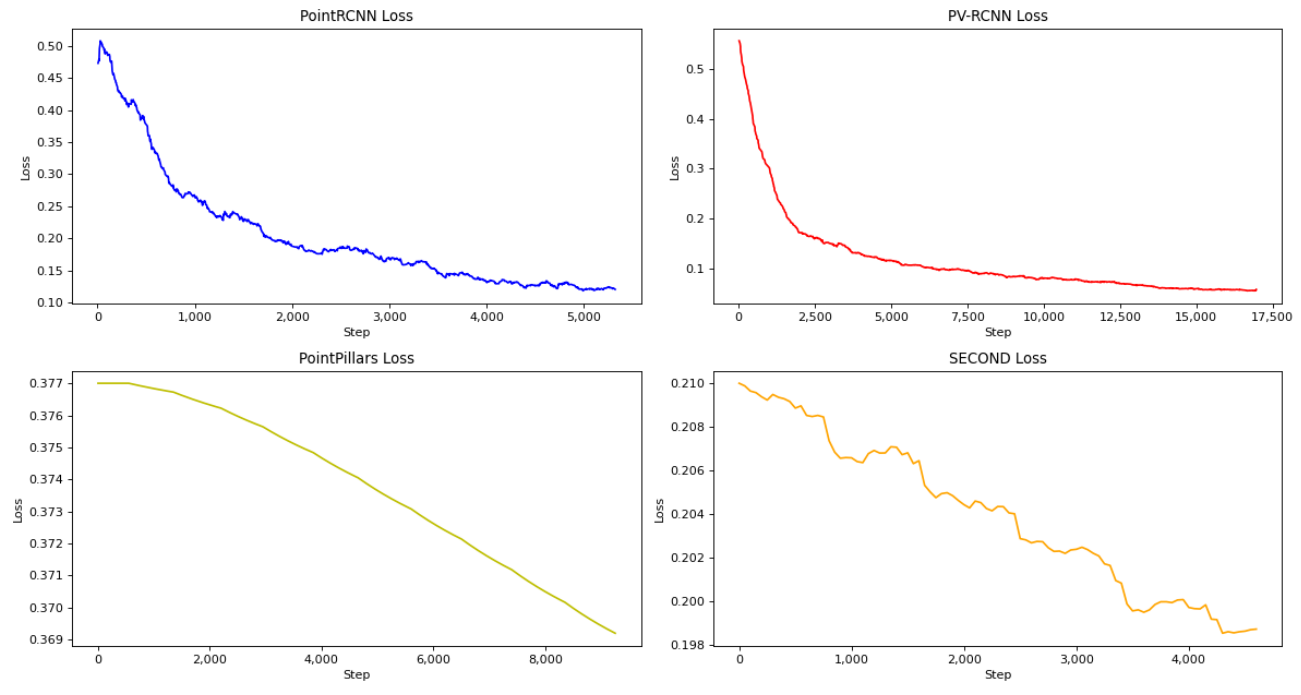
Figure 6. Loss curves of the four networks. Table 5. Detection time.